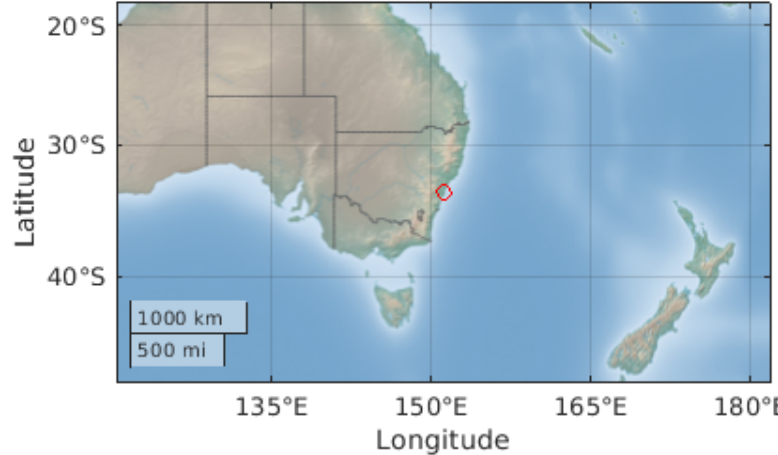
Figure 7. Location of the TrackInk device.